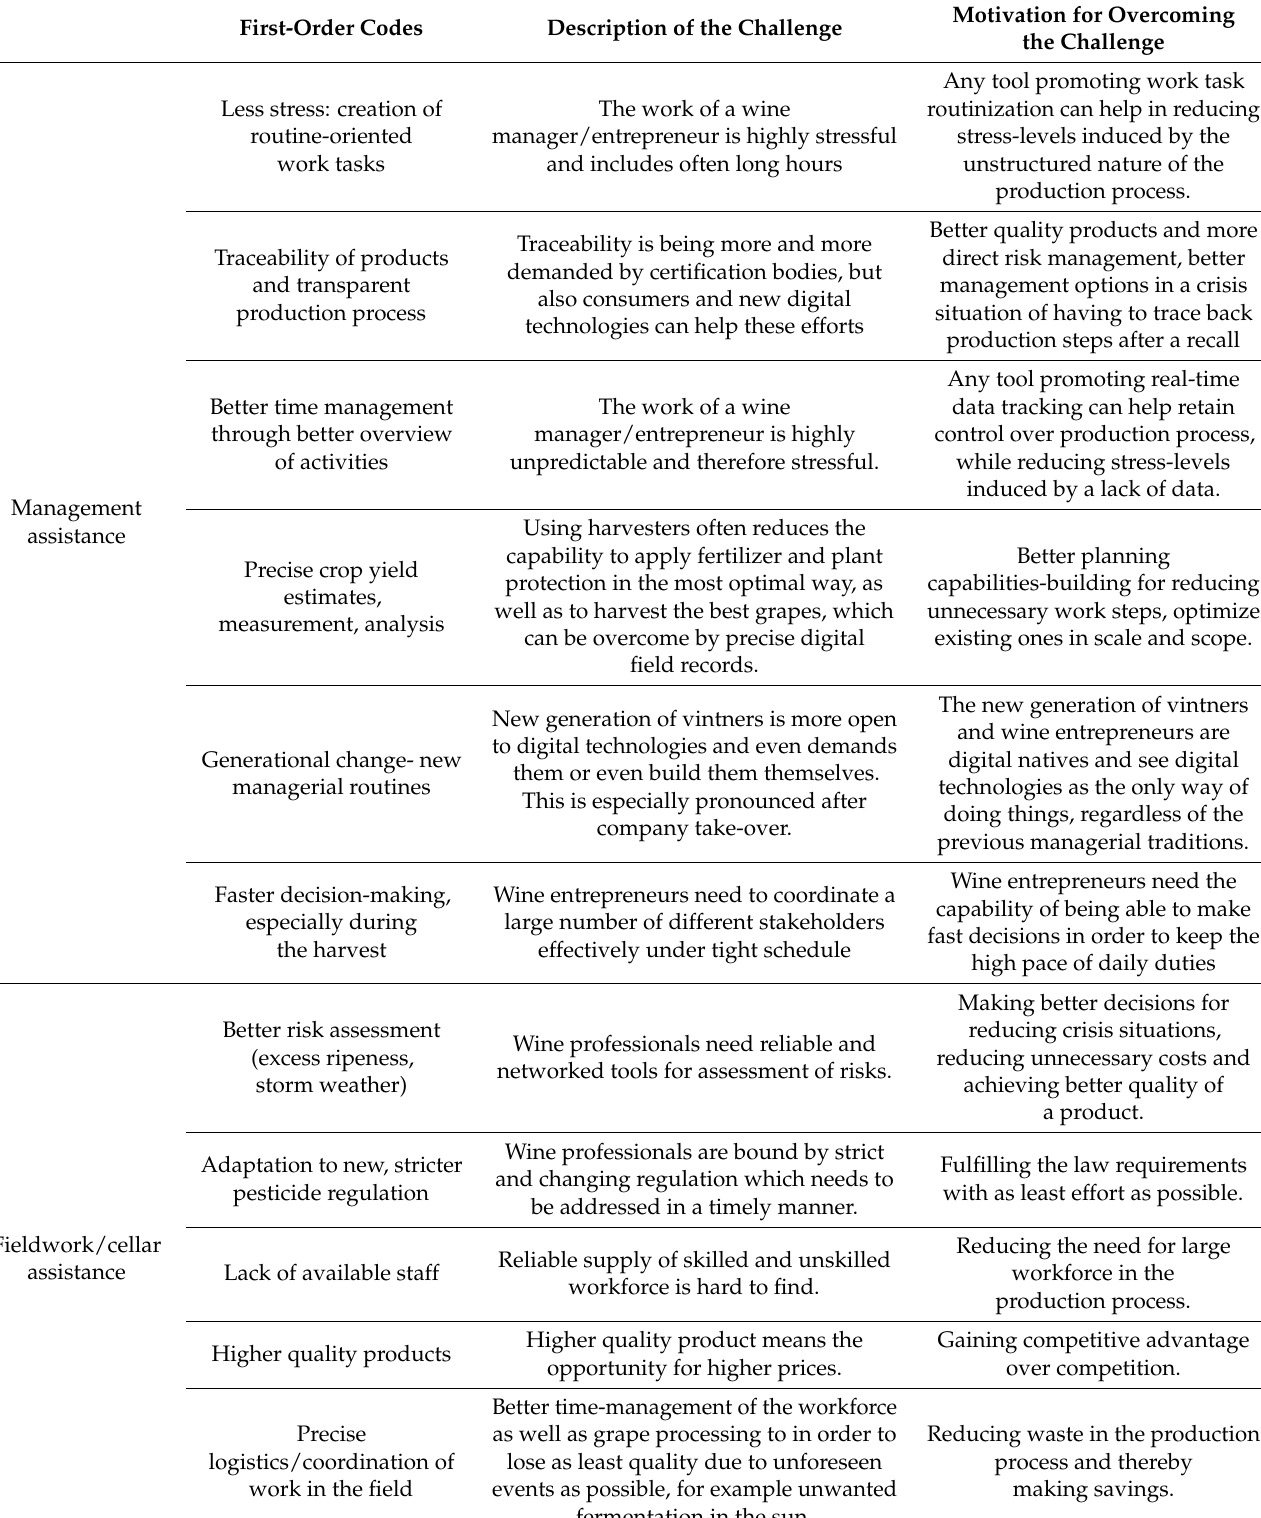
Table A1. Pull strategies for adoption of new grape harvest technology with detailed descriptions and motivations for overcoming the